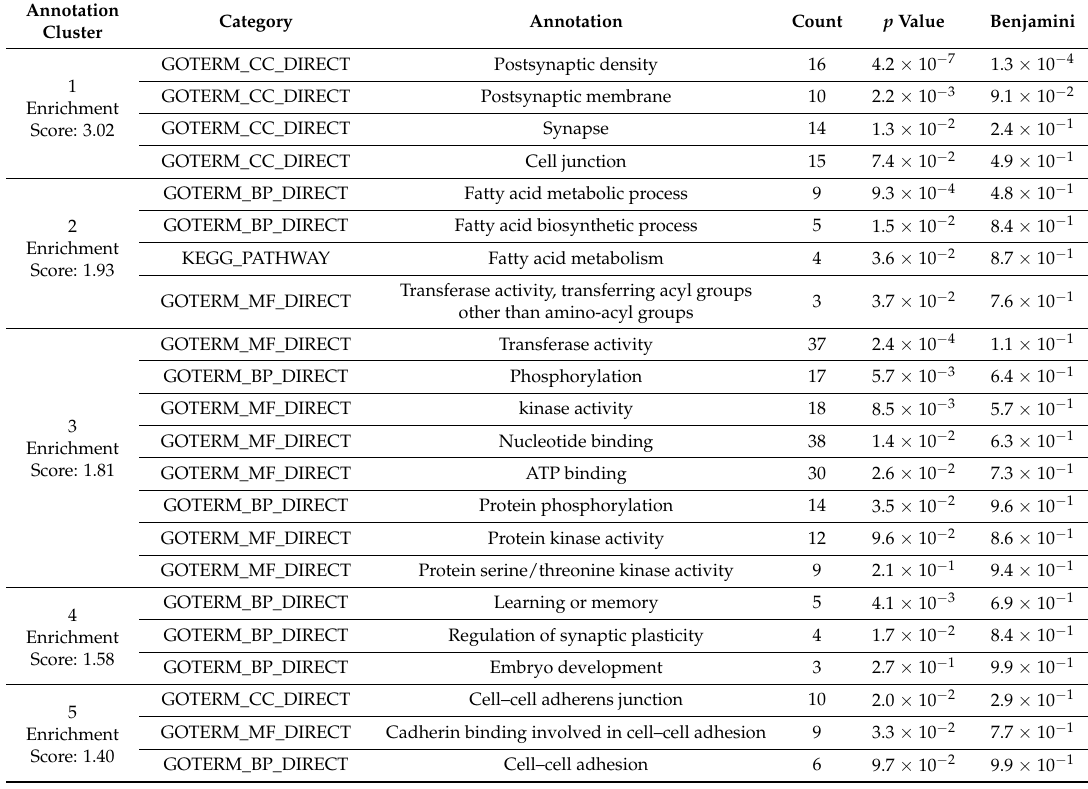
Table 5. The functional annotation clusterings of the 287 overlapped